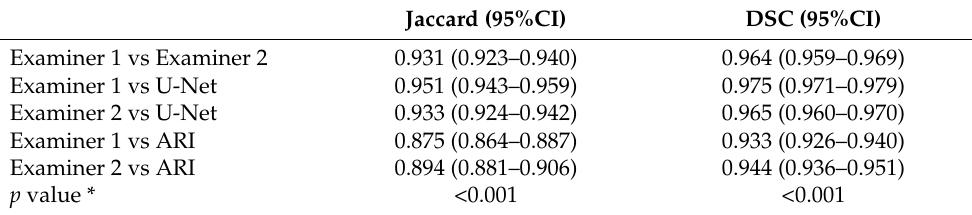
Table 3. Two types of similarity and the results of each Friedman